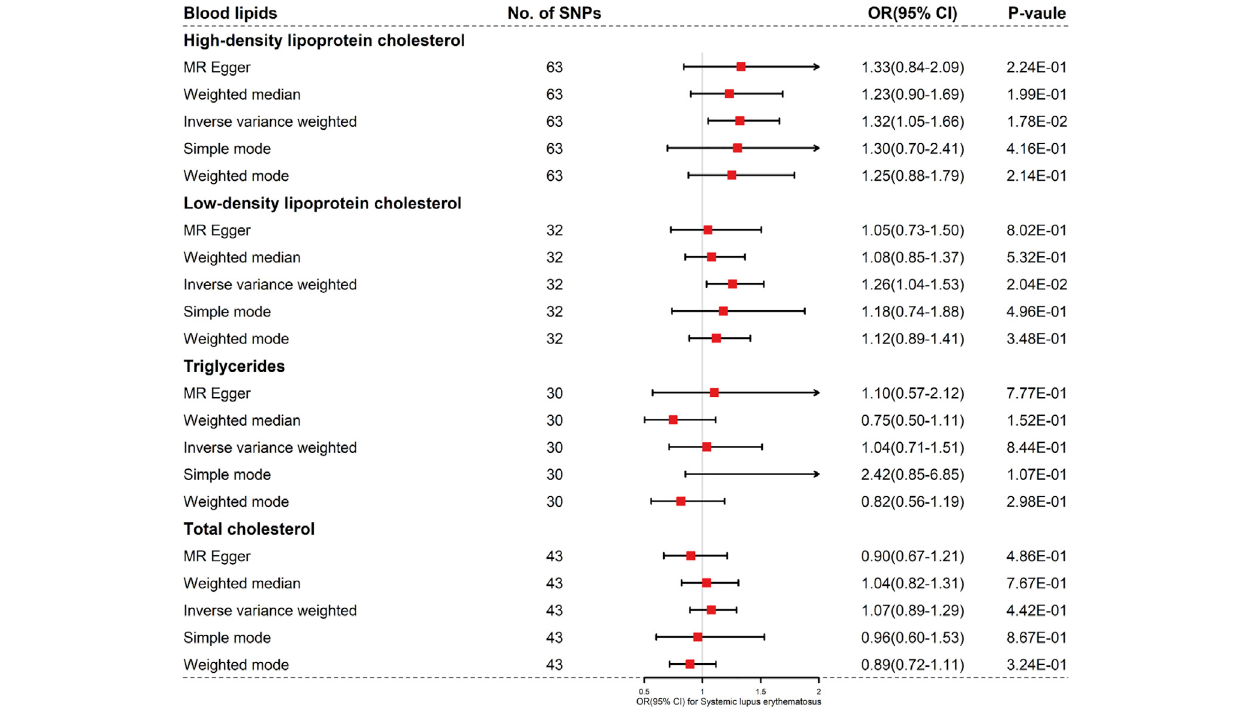
Frontiers in Genetics |